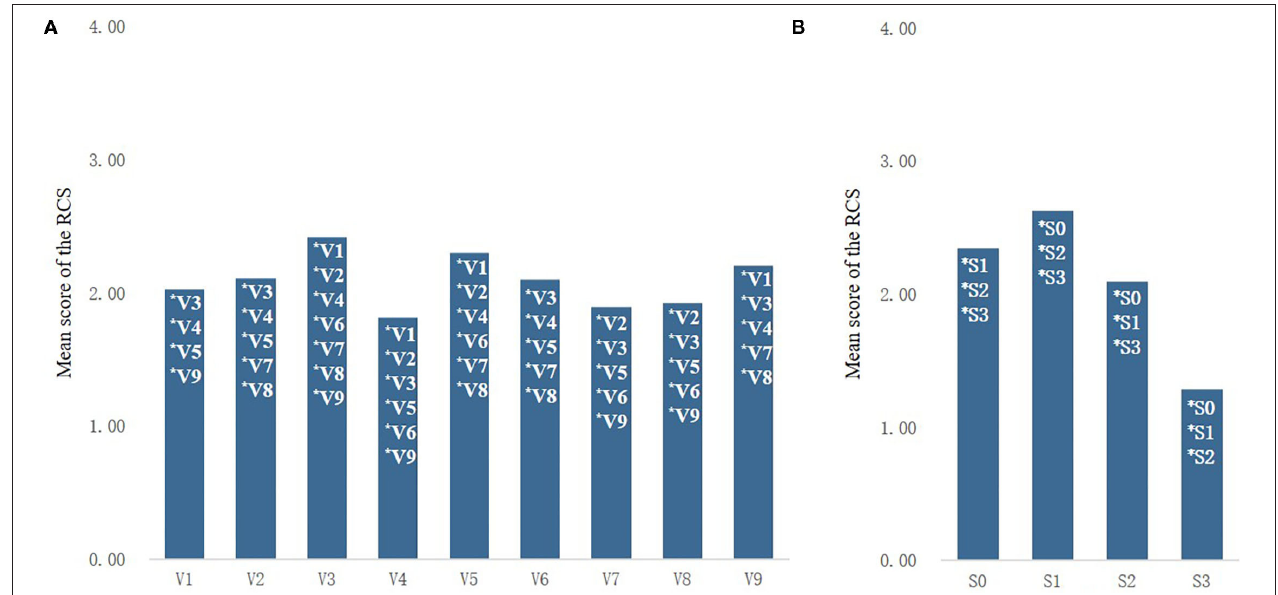
FIGURE 8 | Comparison of RCS scores for different street types (A) and different sound combinations (B)